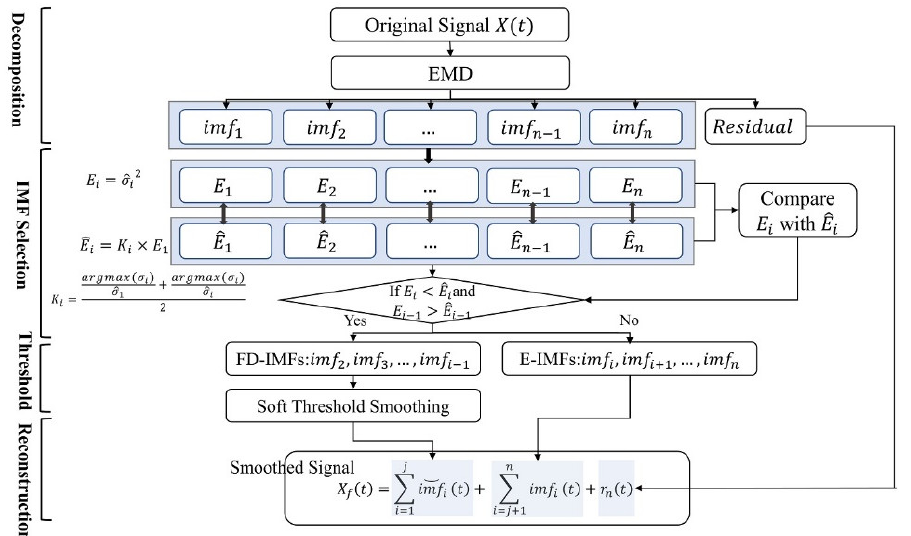
Figure 4. Schematic diagram of EMDT.